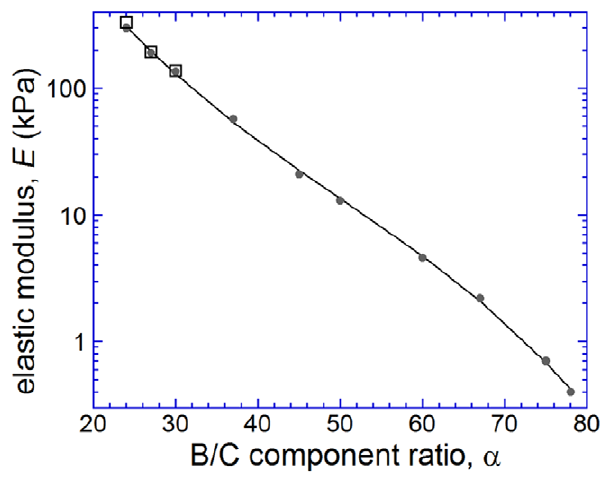
Figure 3. Elastic moduli of gels prepared from Sylgard 184. Elastic modulus, E , of silicone gels prepared by mixing the base (B) and cross-linker (C) components of Sylgard 184 as a function of the component mass ratio, a =B/C. Grey circles are data points from measurements on thin gel layers with the microfluidic device; black squares are data points from tensile tests on gel slabs; continuous line is a fit of the data points to equation 1, log( E ) ~ C 0 z C 1 a z C 2 a 2 z C 3 a 3 , with E measured in kPa and with C 0 , C 1 , C 2 , and C 3 equal to 4.86, 2 0.135, 1 : 22 : 10 { 3 , and 1 : 82 : 10 { 5 , respectively.